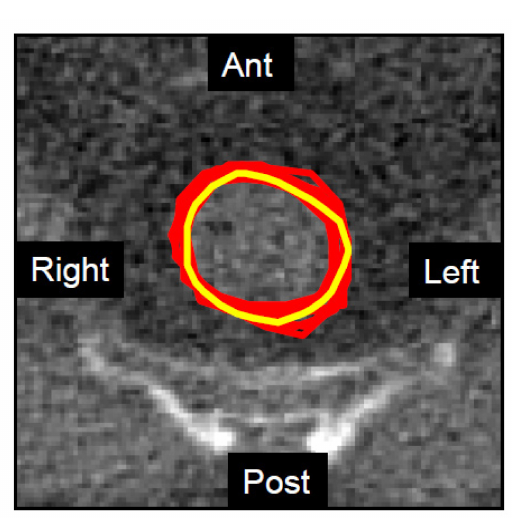
Fig. 4. Example of an MV CT slice of the centre of the pelvis, showing rectal contours from eight senior radiation oncologists (red - median inter-observer JCI of 0.79.) and the automated algorithm (yellow). The median JCI for the automated system for this slice was 0.64. However, visually, the degree of agreement is striking. Ant - Anterior (front of the patient), Post – posterior (back of the patient), Left – left side of the patient (shown on the right of the screen by convention), Right – right of the